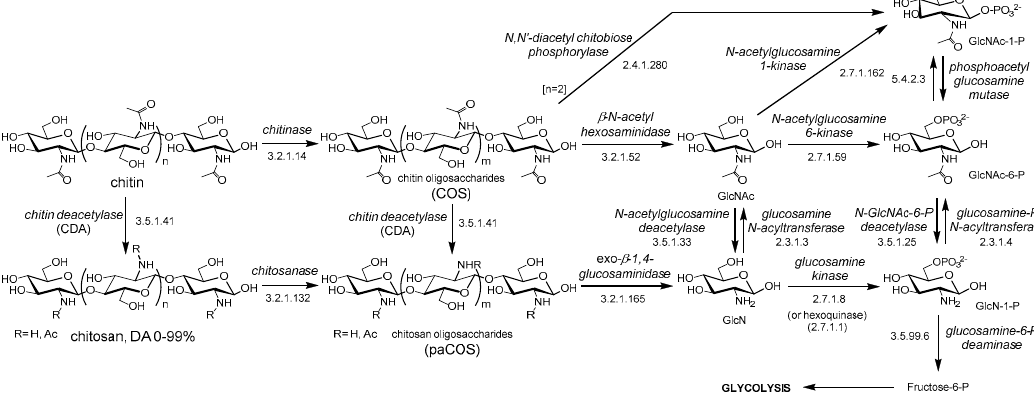
Figure 1. Chitin catabolism. GlcNAc: N -acetylglucosamine; GlcN: glucosamine; DA: degree of acetylation. COS: chitooligosaccharides (or chitin oligosaccharides), paCOS: partially acetylated chitooligosaccharides (or chitosan oligosaccharides).